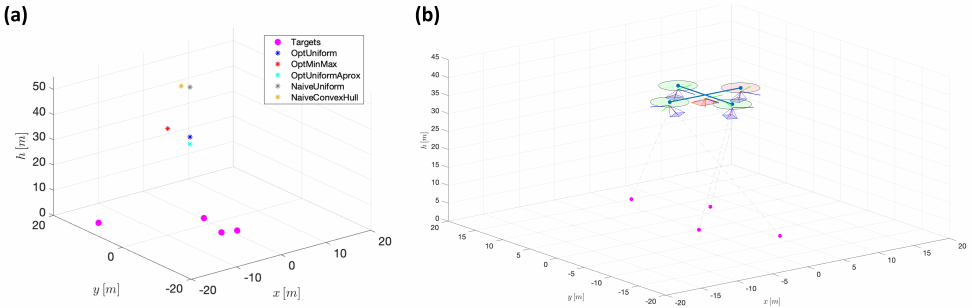
Figure 14. ( a ) Example of reference position provided for each positioning strategy. ( b) Snapshot of the three-dimensional scenario depicting the vehicle.